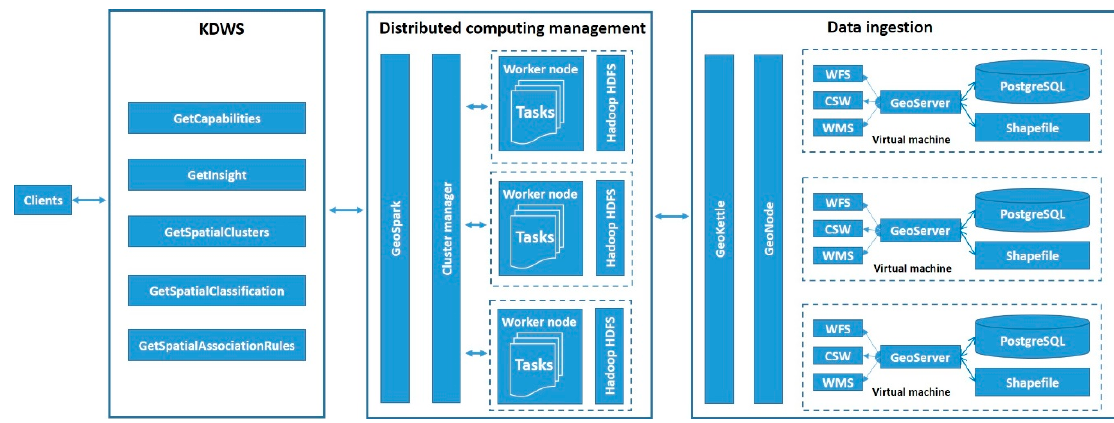
Table 3. The most important geodemographic indicators used for testing of the proposed method- ology.